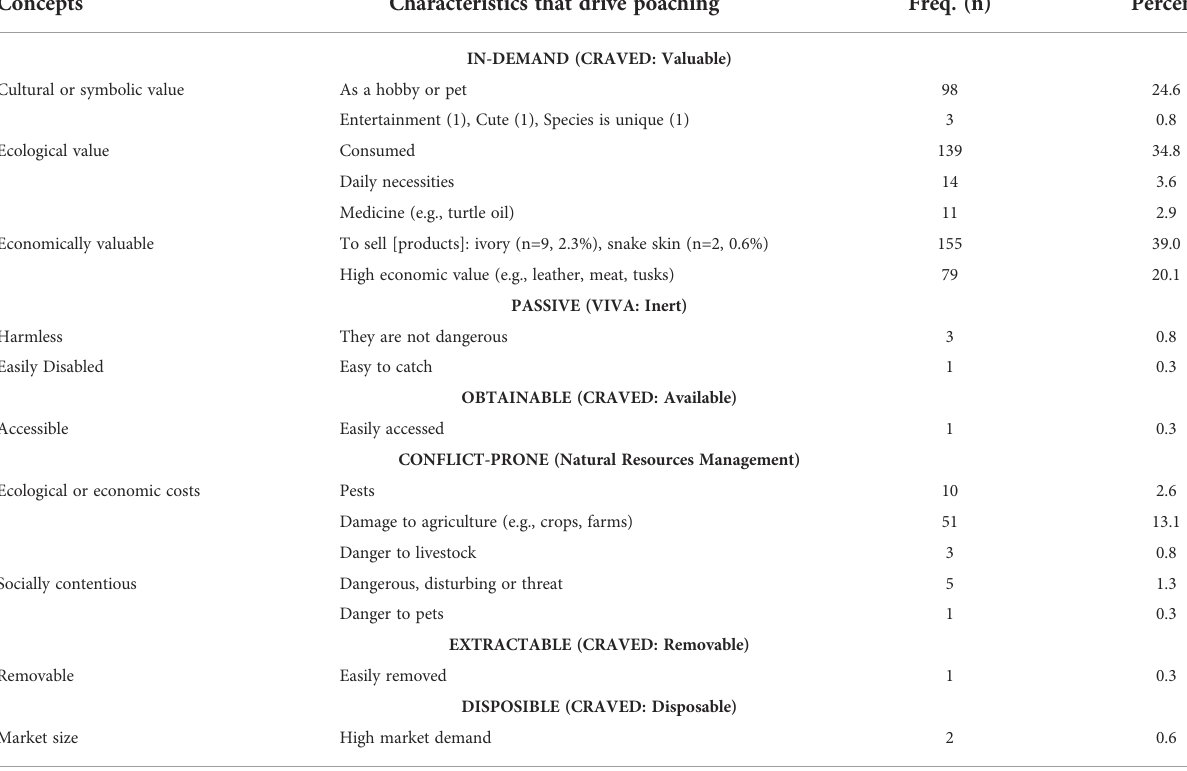
TABLE 4 Community perceptions based on surveys (n=400) of what characteristics drive poaching of particular species in Bukit Barisan Selatan National Park, Sumatra, Indonesia as fi tted to proposed IPOACHED framework.